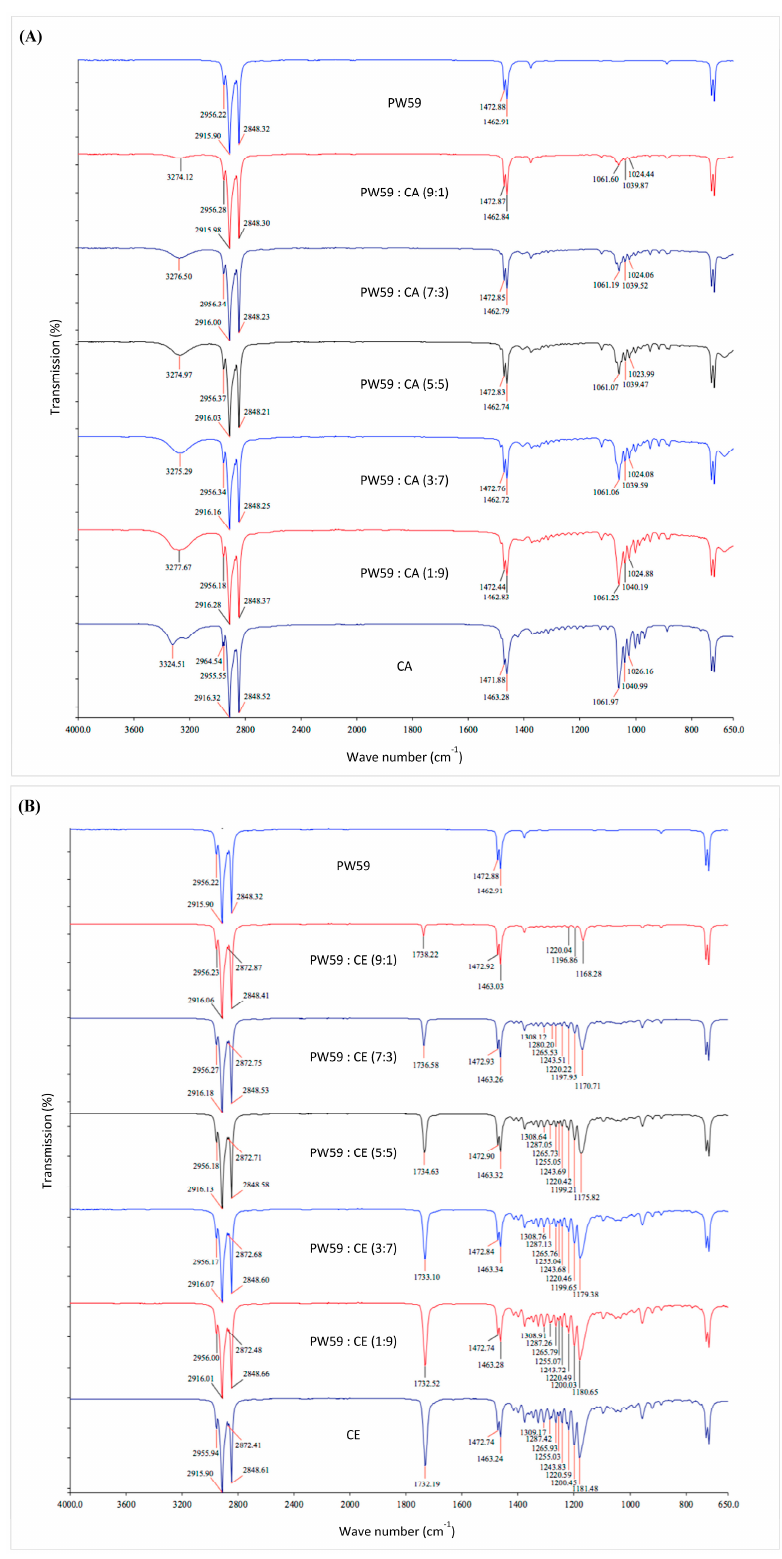
Figure 3. FTIR spectra of ( A ) PW59, CA, and blends; ( B ) PW59, CE, and blends ( n = 3).